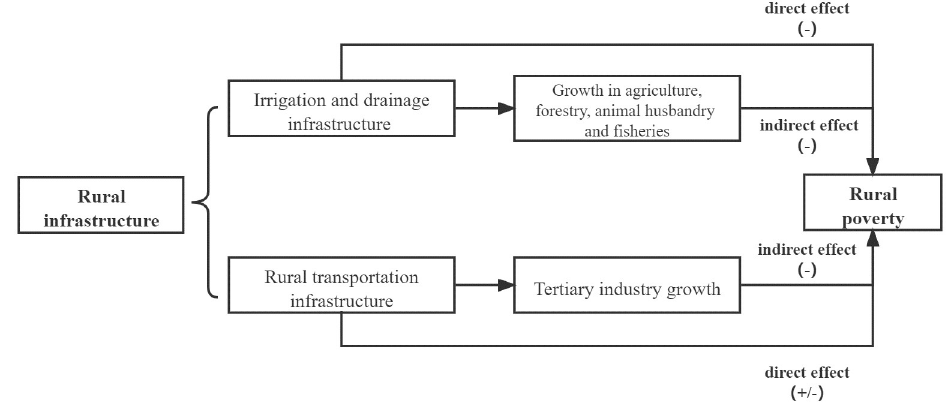
Fig 1. The mechanism of irrigation and drainage and rural transportation infrastructure on poverty. The direct an indirect mechanism of irrigation and drainage and rural transportation infrastructure on poverty.